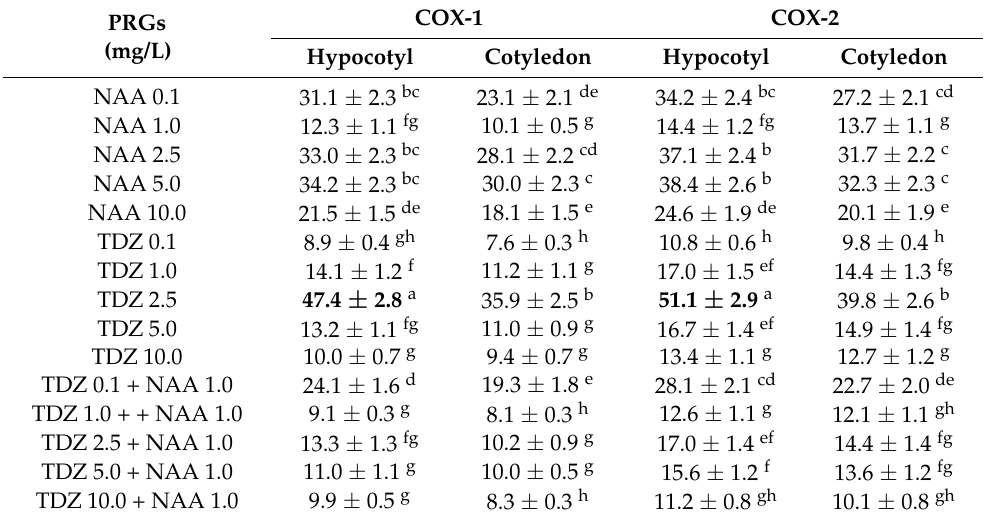
Table 4. Anti-inflammatory potential against COX-1 and COX-2 (in inhibition percentage) of L. grandiflorum extracts from callus cultures (derived from hypocotyl and cotyledon explants) grown under different PGRs treatments (in